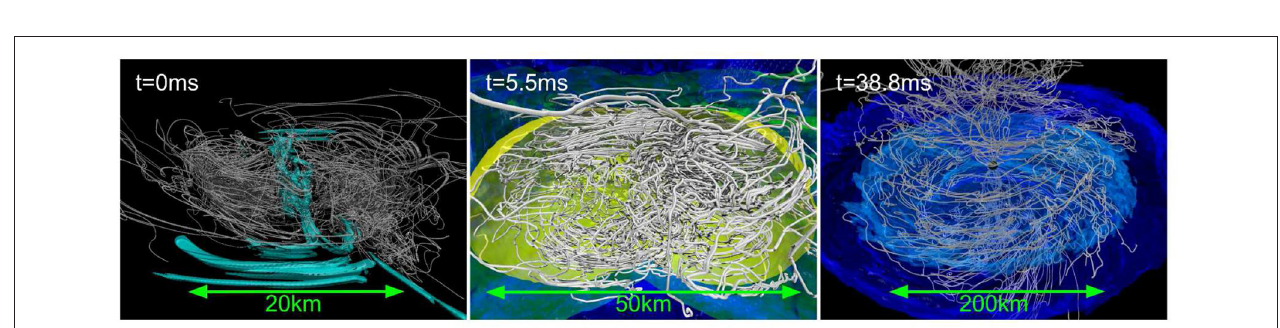
FIGURE 7 | NS rest-mass density and magnetic field lines at t − t mrg ≈ 0.0ms (left) , t − t mrg ≈ 5.5ms (middle) , and t − t mrg ≈ 38.8ms (right) following a NSNS merger. Here t mrg is the merger time. Cyan color on the left panel displays magnetic fields stronger than 10 15.6 G. Yellow, green, and dark blue colors on the middle panel show rest-mass densities of 10 14 , 10 12 , and 10 10 g / cm 3 , respectively. Light and dark blue colors on the right panel indicate rest-mass densities of 10 10.5 , and 10 10 g / cm 3 , respectively (from Kiuchi et al.,